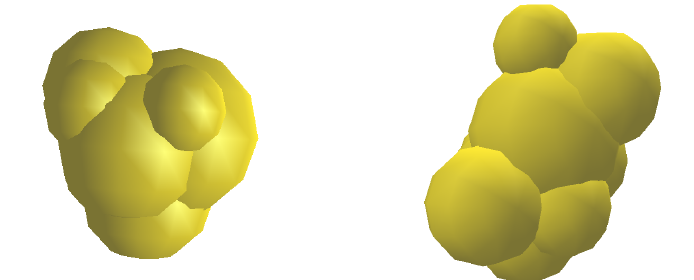
Figure 2. Example of using the overlapped spheres particle model to create the real shape of particles in the discrete element method modeling